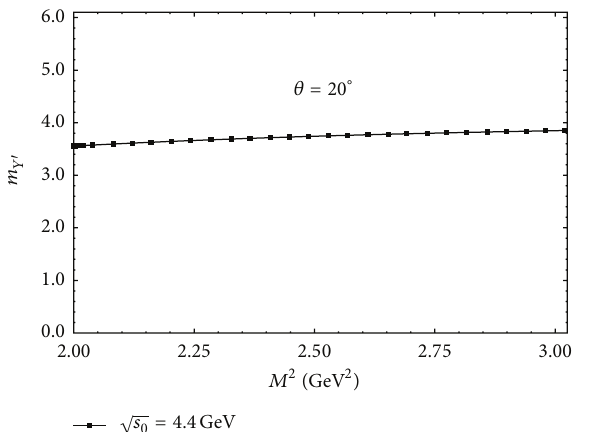
Figure 5: The dependence of the mass of the 𝑌 󸀠󸀠 state on Borel mass square 𝑀 2 for the mixing angle 𝜃 = 20 0 , at the fixed value of the continuum threshold √𝑠 0 = 4.6 GeV.